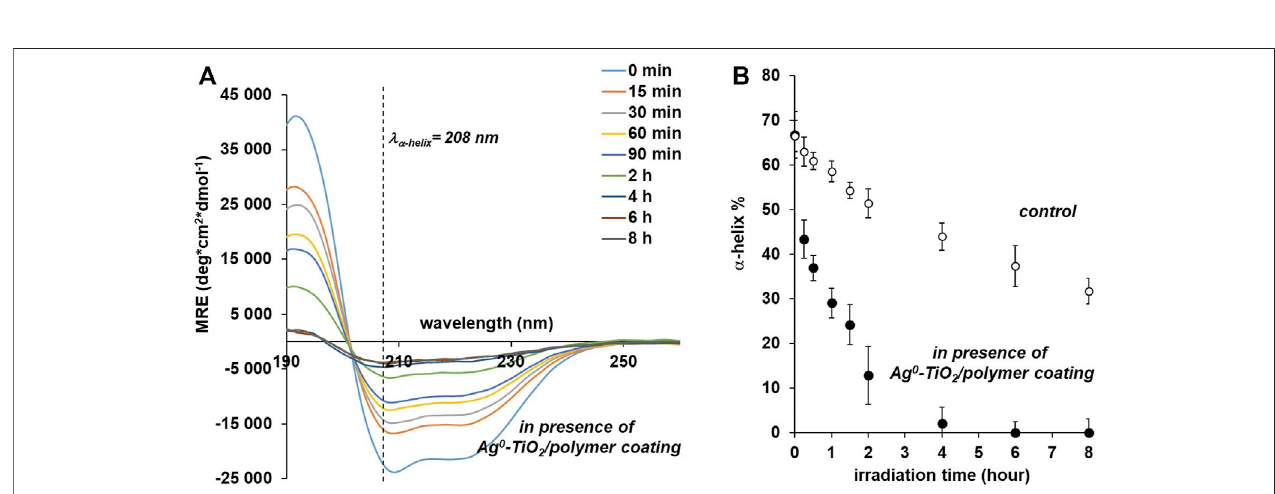
FIGURE6| CD spectra (A) and the α -helix% (B) ofBSAunder photocatalytic degradation test onAg 0 -TiO 2 /polymer nanohybrid coating asafunction ofirradiation time under visible-light illumination.